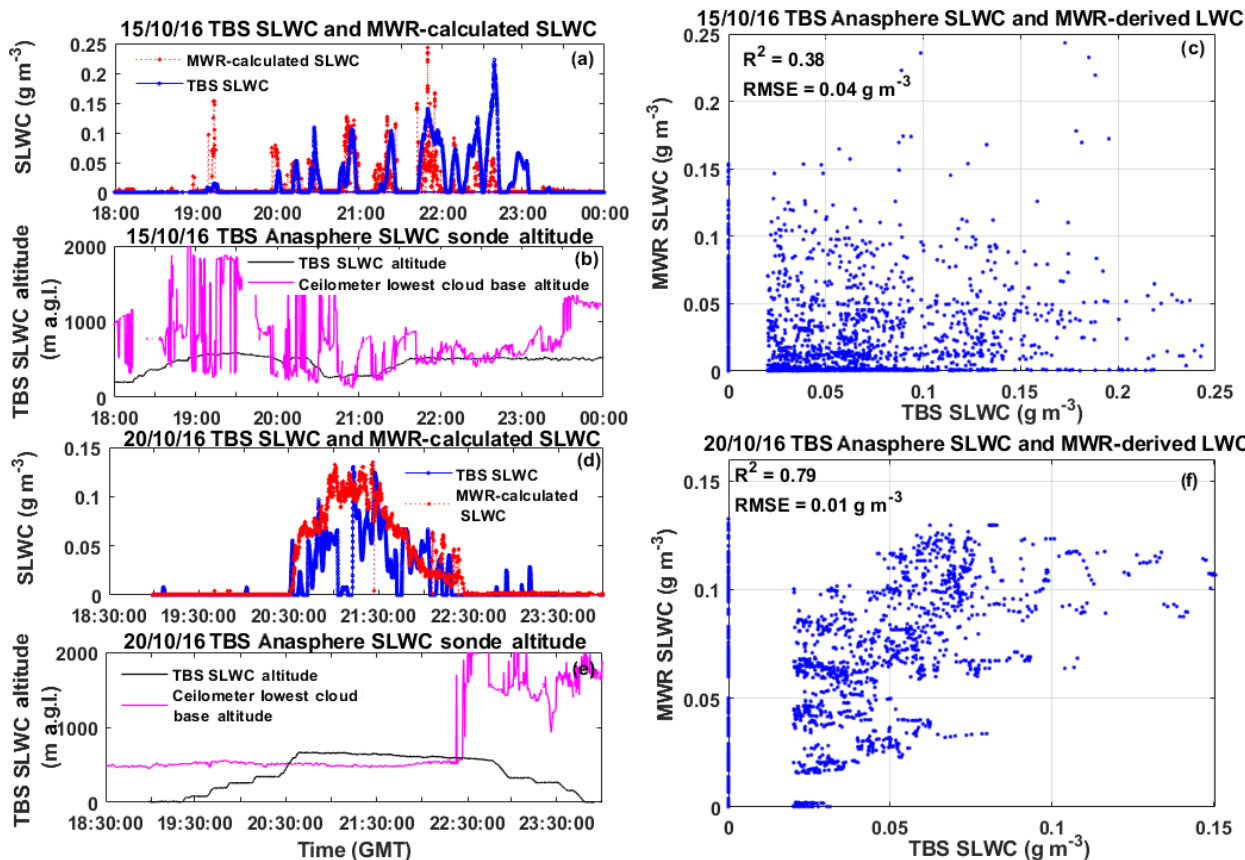
Figure 8. The 15 October 2016 SLWC from TBS Anasphere sonde and calculated from MWR (a) , 15 October 2016 TBS Anasphere sonde and ceilometer cloud base altitude (b) , and 15 October 2016 SLWC from Anasphere sonde vs. SLWC calculated from MWR (c) , 20 October 2016 SLWC from TBS Anasphere sonde and calculated from MWR (d) , 20 October 2016 TBS Anasphere sonde and ceilometer cloud base altitude (e) , and 20 October 2016 SLWC from Anasphere sonde vs. SLWC calculated from MWR (f)